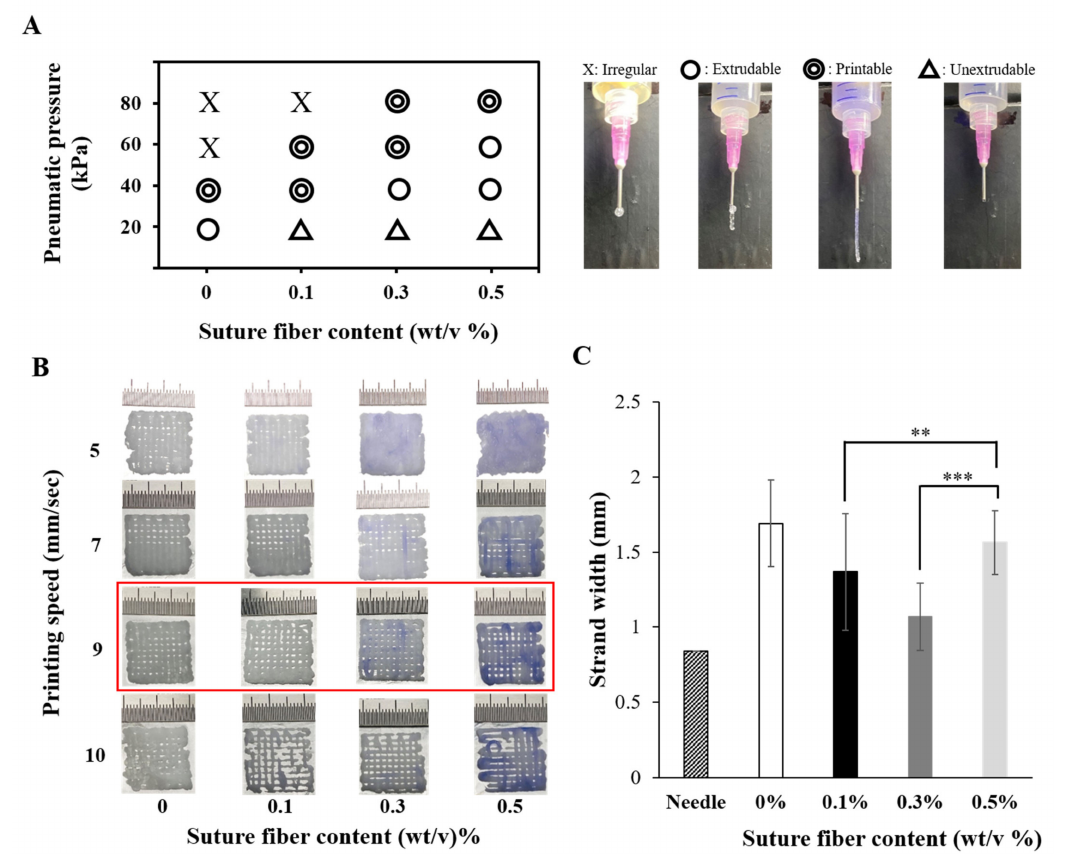
Figure 3. Printability of the biomaterial inks into which suture fibers were added. ( A ) Filament drop test results for determining the proper pneumatic pressure to be used. ( B ) Images of 3D scaffolds fabricated at various printing speeds. ( C ) Printed strand widths measured using vernier calipers. The strand width of the needle indicates the inner diameter of the 18-gauge needle (0.84 mm) used for printing ( n = 6) (** p < 0.01 and *** p <